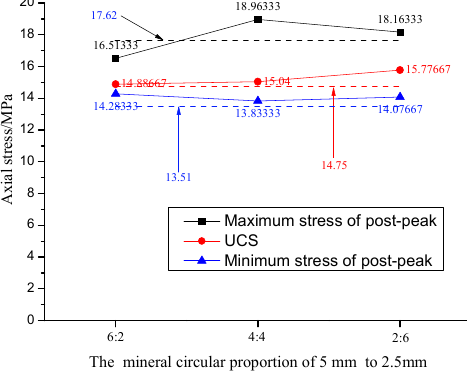
Figure 28. UCS and maximum and minimum stress post-peak for proportions of different size minerals.